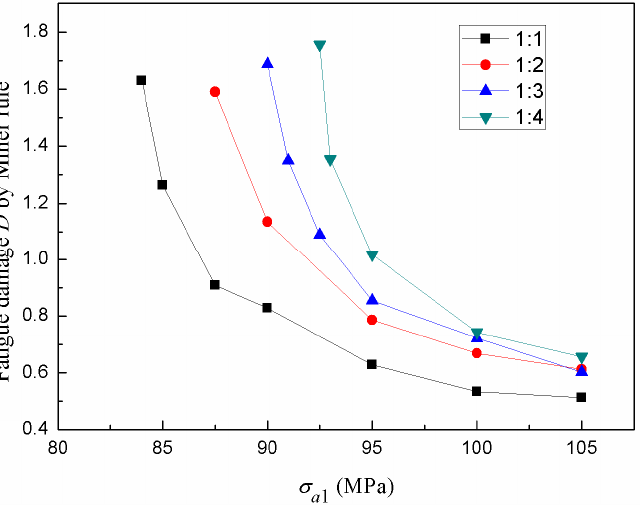
Figure 10. Fatigue cumulative damage of designed T-type specimens under different cycle ratios.